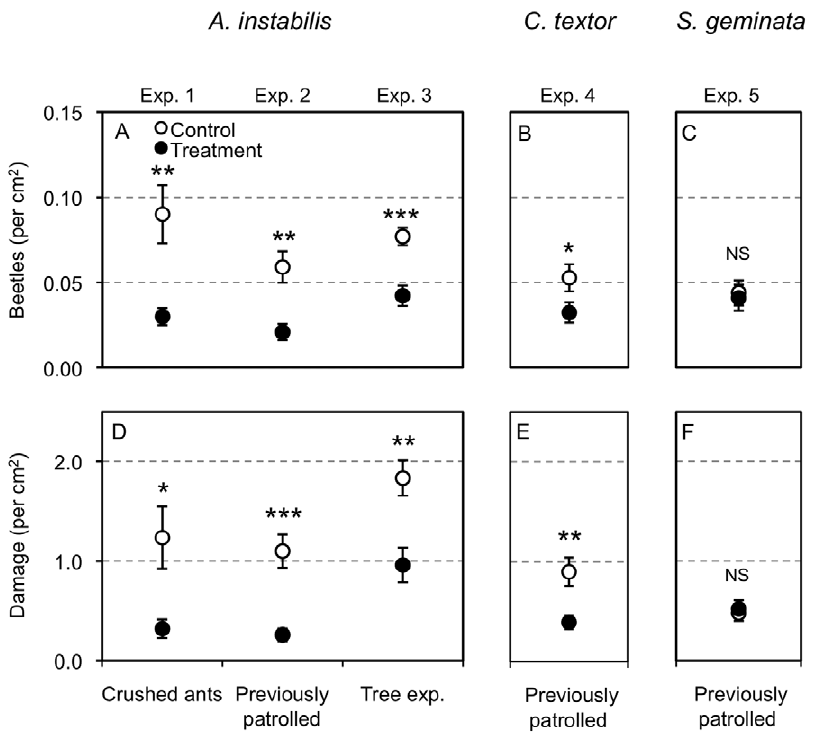
Figure 1. The effect of ant semiochemical treatments on beetle choice and herbivory. Experiments 1–5 treatment means ( 6 SE) for the number of beetles per cm 2 (A–C) and mean damage per cm 2 (D–F). Specifically, Exp. 1 – crushed A. instabilis ant treatment versus control experiment (A,D), Exp. 2 -leaves previously patrolled by A. instabilis versus control experiment (A,D), Exp. 3 -leaves from trees with A. instabilis nests versus leaves from trees without nests (A,D), Exp. 4 -leaves previously patrolled by C. textor versus control leaves experiment (B,E), and Exp. 5 -leaves previously patrolled by S. geminata versus control leaves experiment (C,F). The x-axis represents the method of ant-treatment for each experiment. Statistical differences between ant and control treatment means are represented as: NS= P . 0.05, *= P , 0.05, **= P , 0.01, ***= P , 0.001.